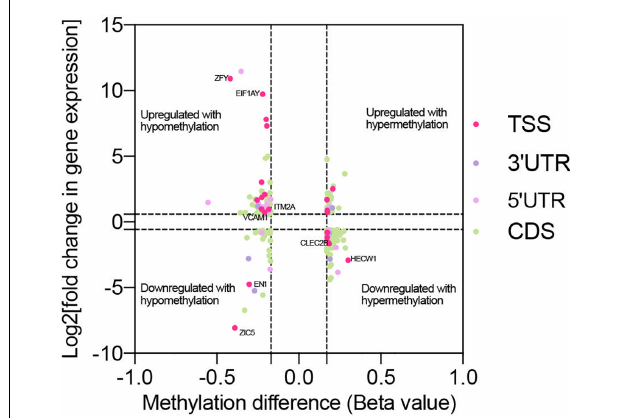
FIGURE 5 | Co-analysis of genes with significant change in methylation and expression level. Scatter plot reveals the distribution of genes with differential methylation and expression. The genes were screened out with the threshold of | Beta value| > 0.17, log2| fold change| > 1 and p < 0.05. Based on the region of methylation, genes were labeled with different